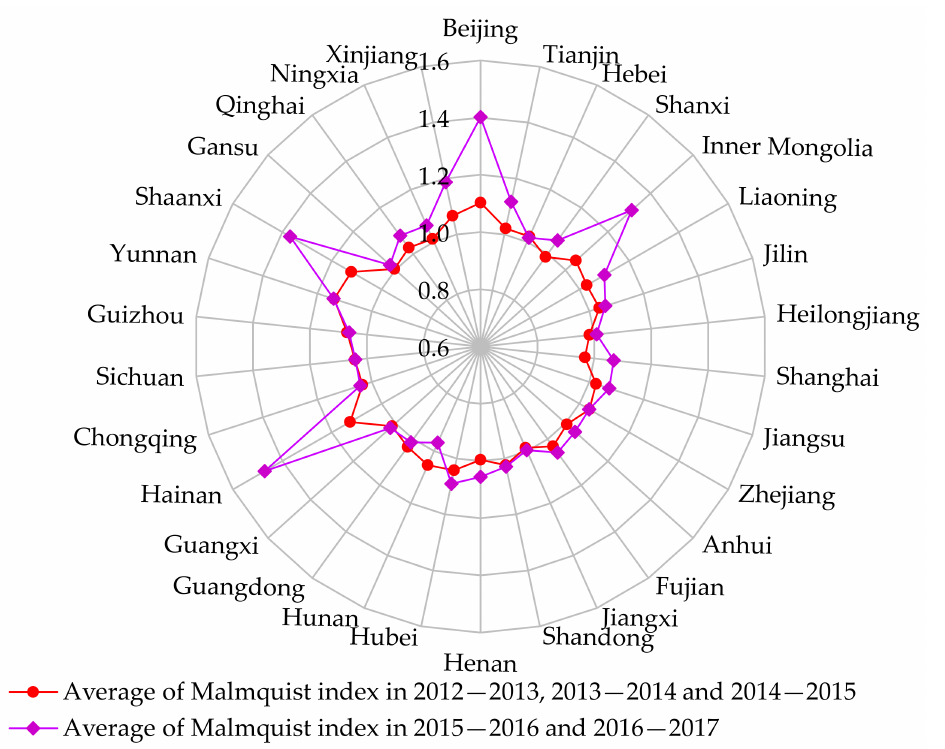
Figure 6. The Malmquist index of the industrial sector in various provinces from 2012–2017.